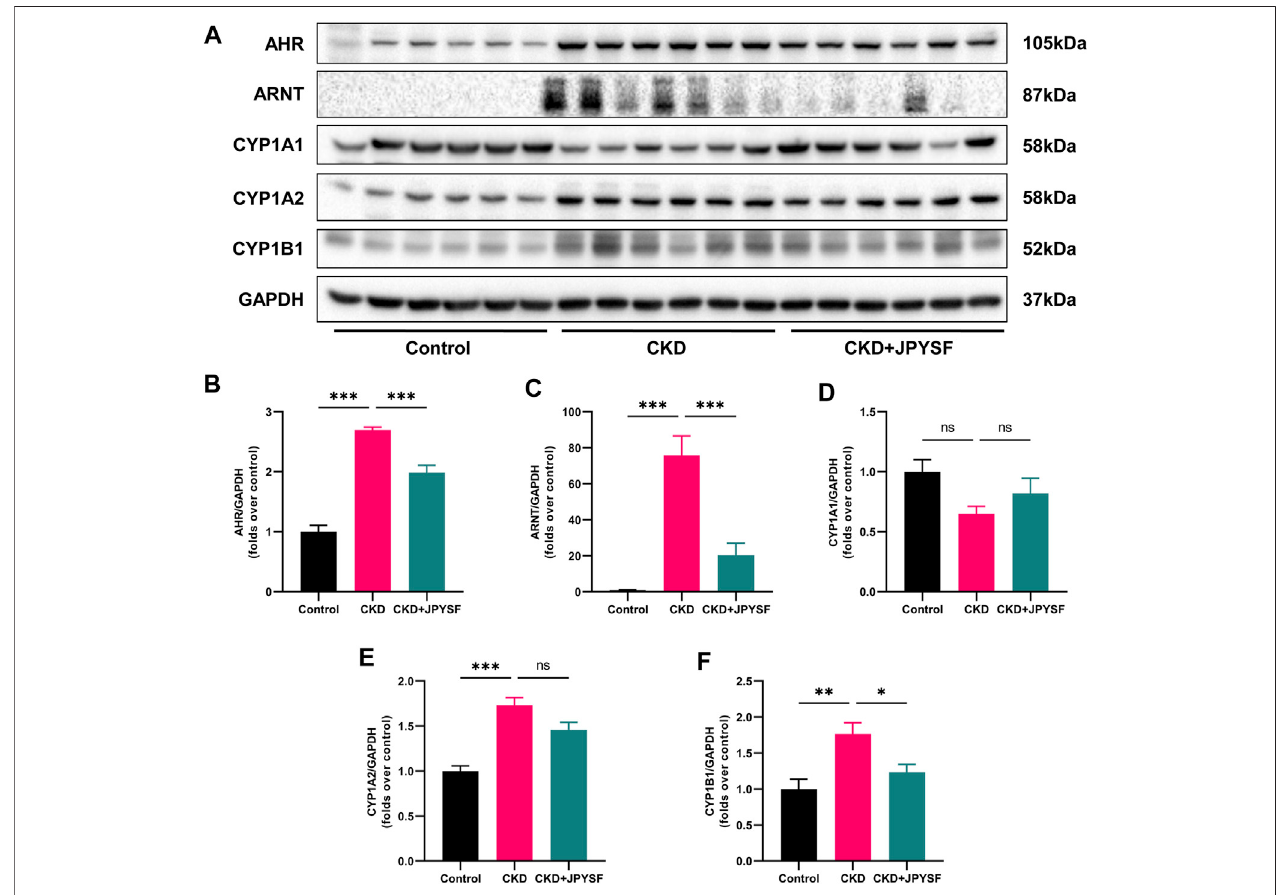
FIGURE 6 | Effects of JPYSF on AHR signaling in adenine-induced CKD rats. (A) Representative Western blot images of AHR, ARNT, CYP1A1, CYP1A2, and CYP1B1 expression in the kidneys of rats. (B – F) Densitometric analysis of AHR, ARNT, CYP1A1, CYP1A2, and CYP1B1 normalized to GAPDH content. Values are expressed as mean ± SEM, n = 6 rats per group (* p < 0.05, ** p < 0.01, and *** p < 0.001 between the indicated two groups, ns means not signi fi